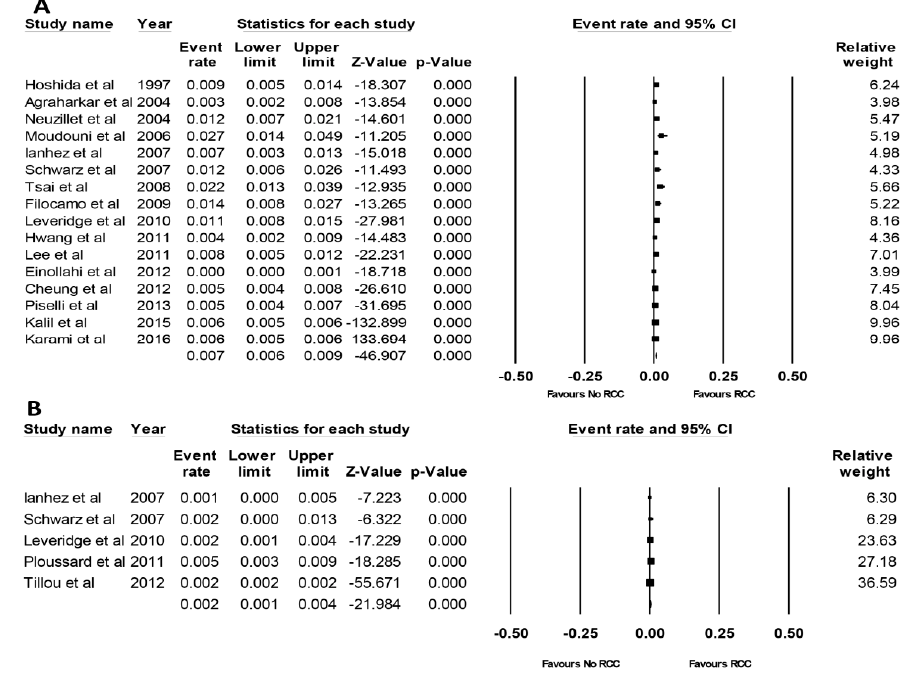
Figure 3. Forest plots of the included studies [11–18,28,29,31,32,34,35,38,39] assessing incidence rates of ( A ) de novo RCC in the native kidney and ( B ) RCC in the allograft kidney [17,19,20,38,39]. A diamond data marker represents the overall rate from each included study (square data marker) and 95% confidence interval.